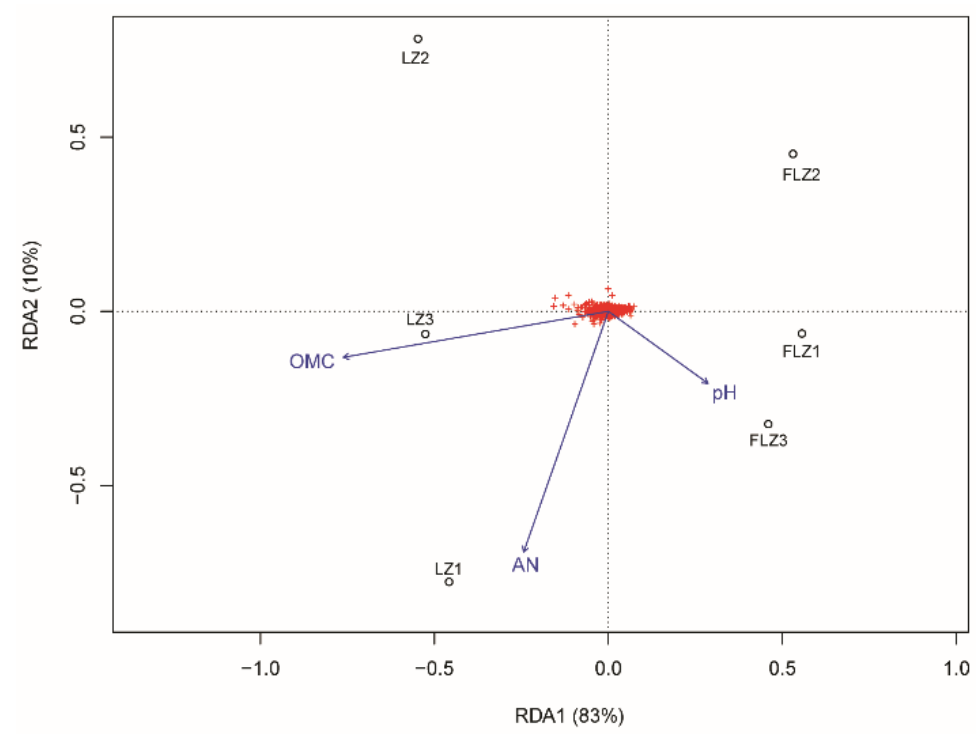
Figure 6. Redundancy analysis (RDA) of the OTUs data and soil chemical properties for individual sample from different treatments. LZ1, FLZ, LZ2, FLZ2, LZ3 and FLZ3 represent the soil samples collected from continuous cropping (LZ) and main cropping (FLZ) at the 4 May (LZ1 and FLZ1), 14 July (LZ2 and FLZ2) and 19 September (LZ3 and FLZ3), 2016. OMC and AN represent organic matter contents and available nitrogen, respectively.